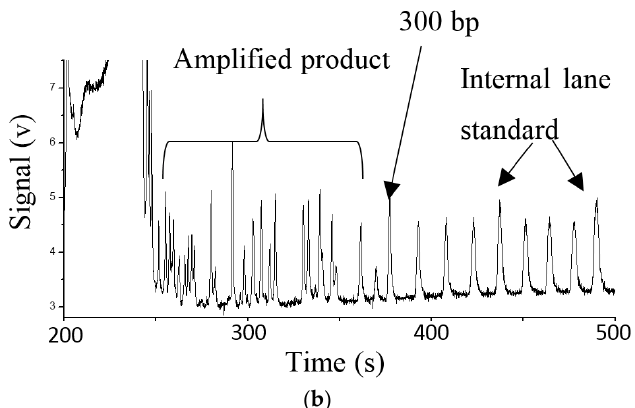
Figure 4. ( a ) DNA profile obtained from off-chip capillary electrophoresis separation of 10 loci amplified on HSA-based PCR device [8]. Electropherogram provided is a screen shot reproduced from Genemarker ® software (SoftGenetics, State College, PA, USA). PCR consisted of 30 cycles and took 19 min. y -axis range from 0 to 10,000 RFUs; ( b ) Electropherogram obtained when separating 6 loci on-chip on single-color separation system built in-house [9].